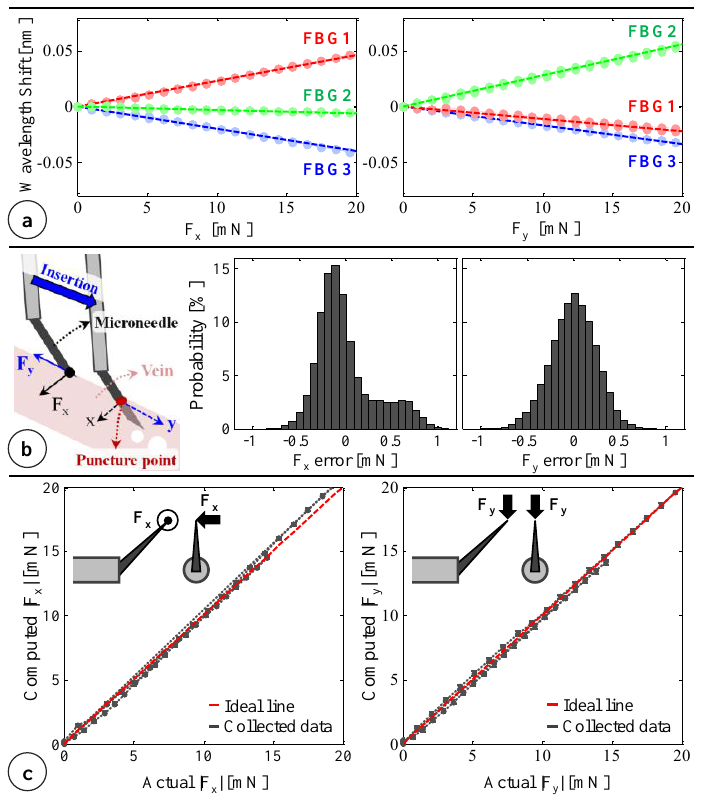
Figure 5. ( a ) Calibration results: linear response for all FBGs when the needle is loaded along x and y axes; ( b ) The force-sensing coordinates relative to the target vein and the histogram of residual errors in each direction; ( c ) Computed forces vs. the actual forces along the x and y axes [62]. The wavelength resolution of our optical sensing interrogator is 1 pm. Based upon the obtained calibration matrix, this corresponds to a resolution of about 0.25 mN for both F x and F y . The optical sensing interrogator has a scan rate of 1 kHz, and the time constant of the sensor is about 5 ms [64], providing a fast enough response for accurate tracking of quick force variations in RVC. To validate sensor operation, the tool tip was loaded/unloaded repeatedly at three different orientations (0°, 45° and 90°). Twenty different load conditions (0–20.6 mN) were tested at each orientation, and each case was repeated six times (three load/unload cycles). For each test, 1000 samples were recorded at a rate of 200 Hz. Overall, the computed forces were observed to closely predict the actual forces with root mean square errors of 0.31 mN and 0.24 mN respectively for F x and F y . The histograms of the residual errors (Figure 5b) show that the probability of errors beyond 0.5 mN is very low, especially for 0–10 mN range, where a closer fit to the ideal straight line (slope = 1) passing through the origin in Figure 5c is visible between the computed and actual forces. Above 10 mN, although F y accuracy is preserved, F x is observed to gradually deviate from the ideal line as the loading is increased. This also leads to